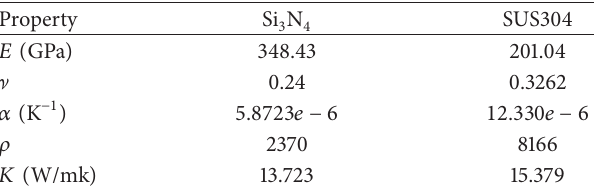
Table 2: Material properties of FG microbeam